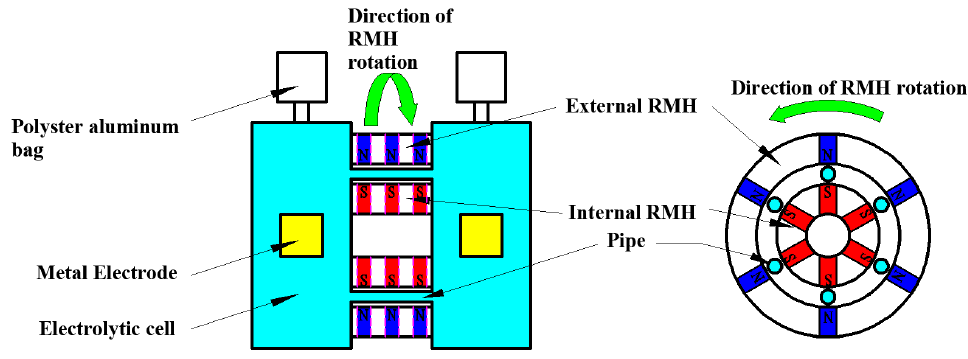
Figure 2. Schematic diagram of the structure of the experimental setup.